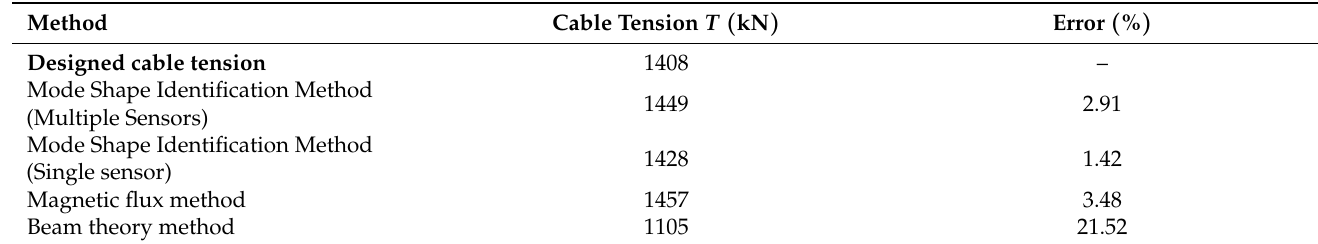
Table 5. Comparison of different methods for cable tension